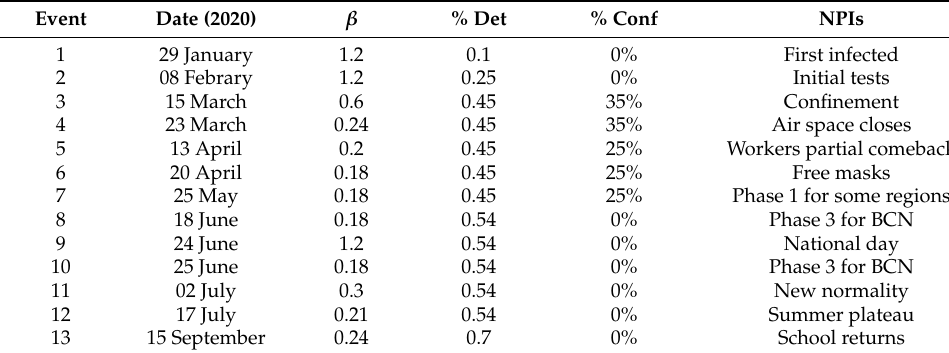
Table 3. Parameters for model 2.5 to be considered due to NPIs. % Det denotes real cases report- ing